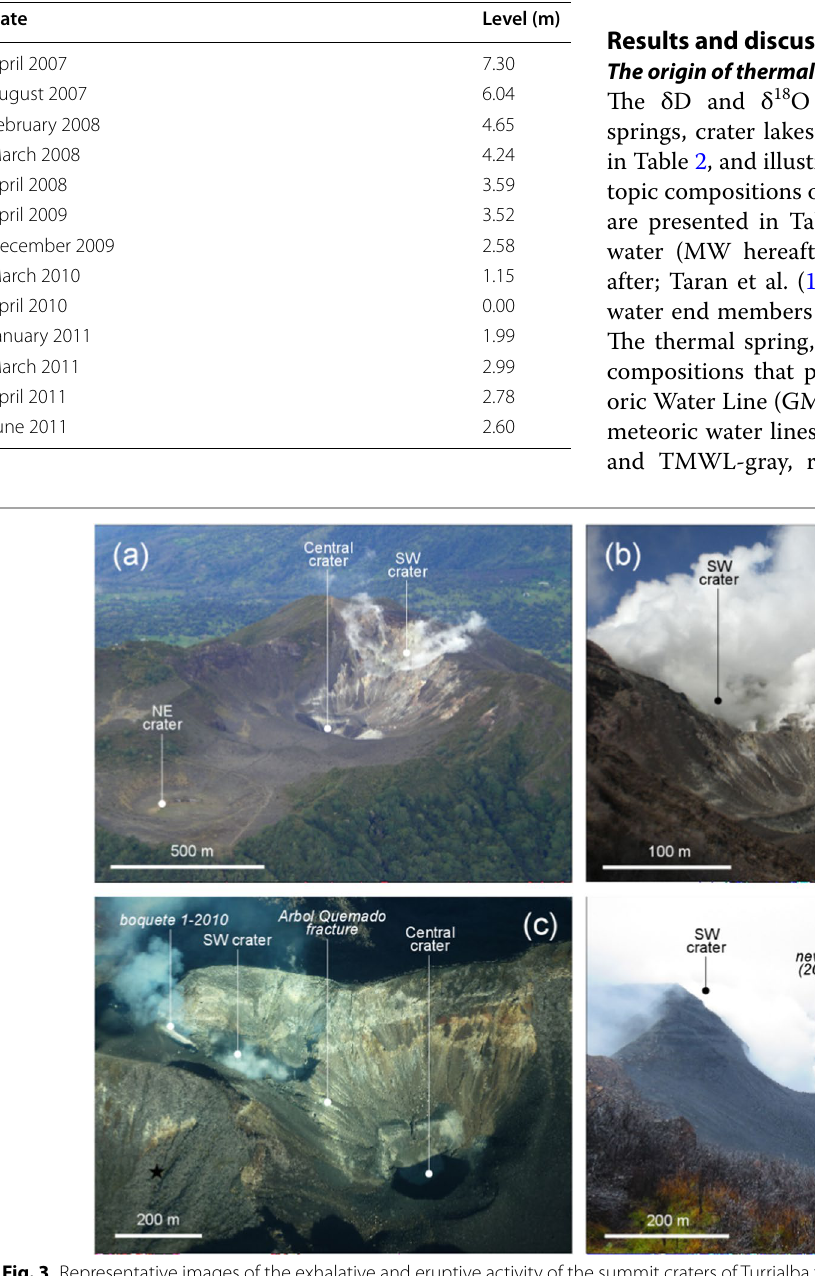
Fig. 3 Representative images of the exhalative and eruptive activity of the summit craters of Turrialba from 2007 to present times. a View from the north in April 2007 with a diffuse fumarolic degassing from the SW crater. b View from the east in December 2009 showing an increased gas discharge from the SW crater. c Aerial view in 2011 showing the location of “boquete 1–2010” vent and Arbol Quemado fracture along the flanks of SW crater. Note to the south (black star) the burned native mountain forest due to acidic rains related to gas emission from the “boquete 1–2010” vent. d View from the east in December 2014 of the new crater opened along the flank between the SW and Central craters of Turrialba during the latest eruptive cycle (ongoing at the moment of writing). Note the substantial thickness of ash and blocks related to this eruptive cycle largely covering the flanks of Central crater (black star), which is filled by an ephemeral lake. Pictures by R. Mora‑Amador ( a , d ), D. Rouwet ( b ) and